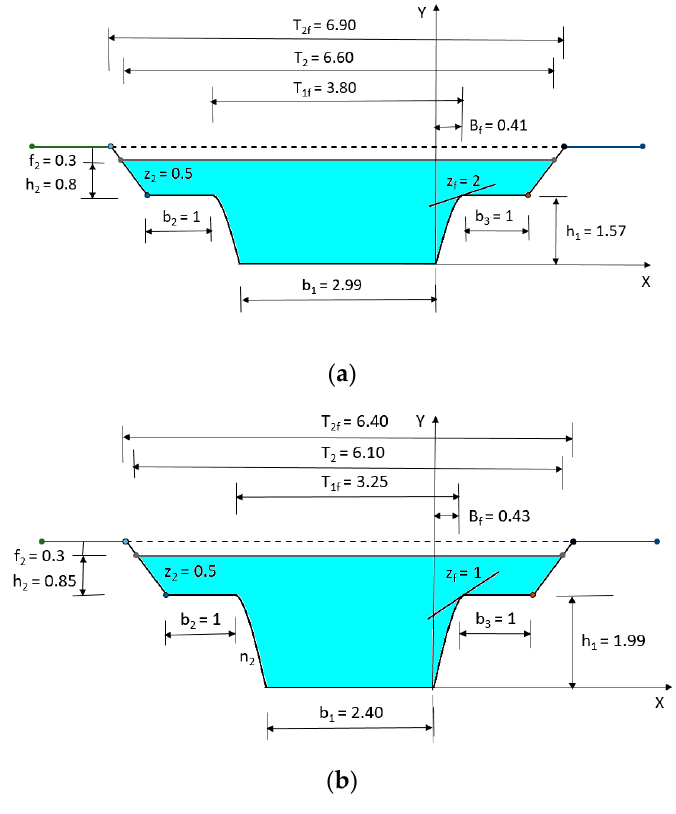
Figure 4. Optimal compound section corresponding to the E-AZ method (dimensions are in meters): ( a ) Restriction z f = 2 and ( b ) restrictions T 2f = 6.4 m and 0.3 ≤ ( h 2 /H ) ≤ 0.45. ( a ) Restriction z f = 2 and ( b ) restrictions T 2 f = 6.4 m and 0.3 ≤ ( h 2 / H ) ≤